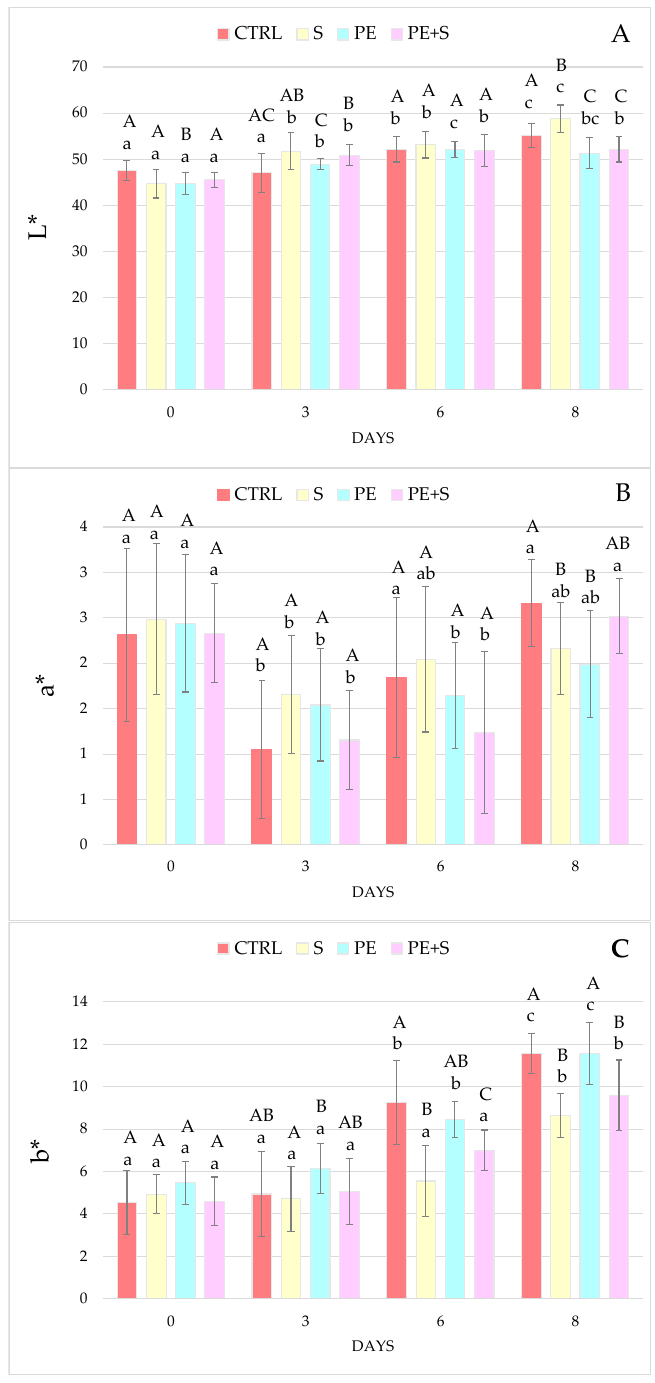
Figure 2. Color changes at days 0, 3, 6, and 8 of storage, in control (CTRL), sulphites (S), phenolic extract (PE), and phenolic extract + sulphites (PE+S) shrimps. Values are means ± standard deviation. Different uppercase letters, within each day of storage, represent significant differences between groups ( p < 0.05); different lowercase letters, within each group, represent significant differences between days of storage ( p < 0.05). L* ( A ), a* ( B ), and b* ( C ).